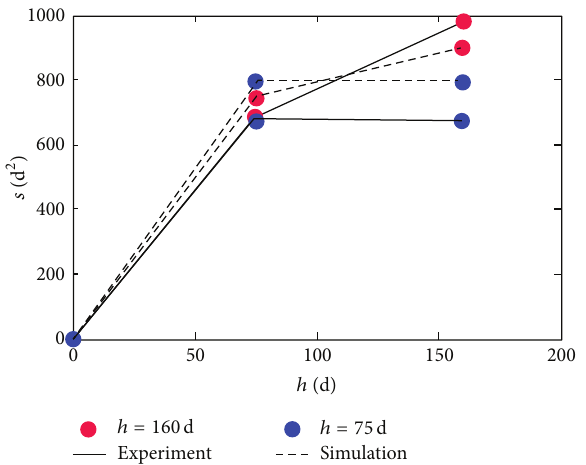
Figure 8: The relationship between the height of the pebble bed and the area of the stagnant zone about the experimental and simulation results.